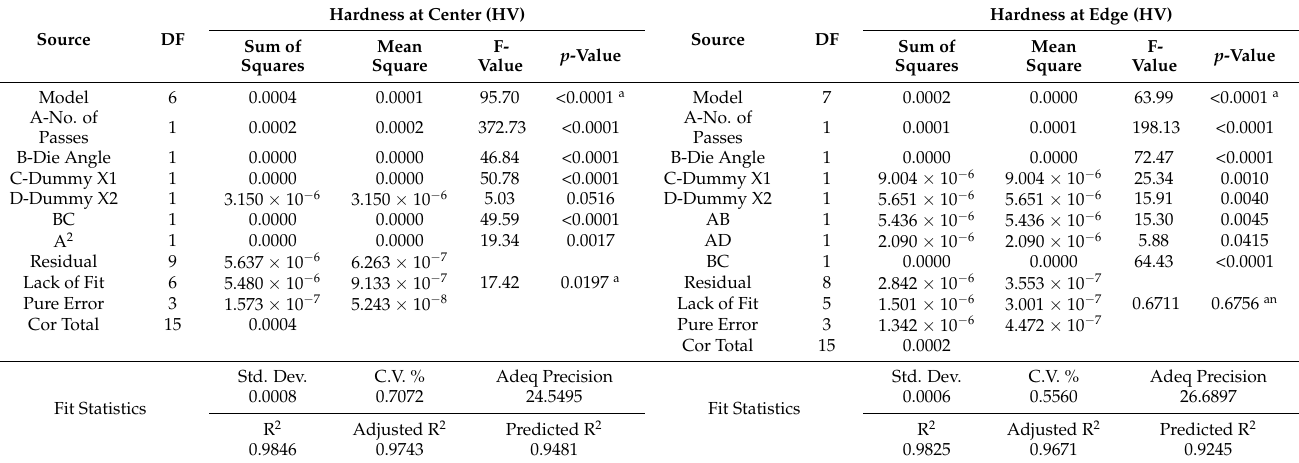
Table A3. Analysis of variance of hardness at the center and edge.